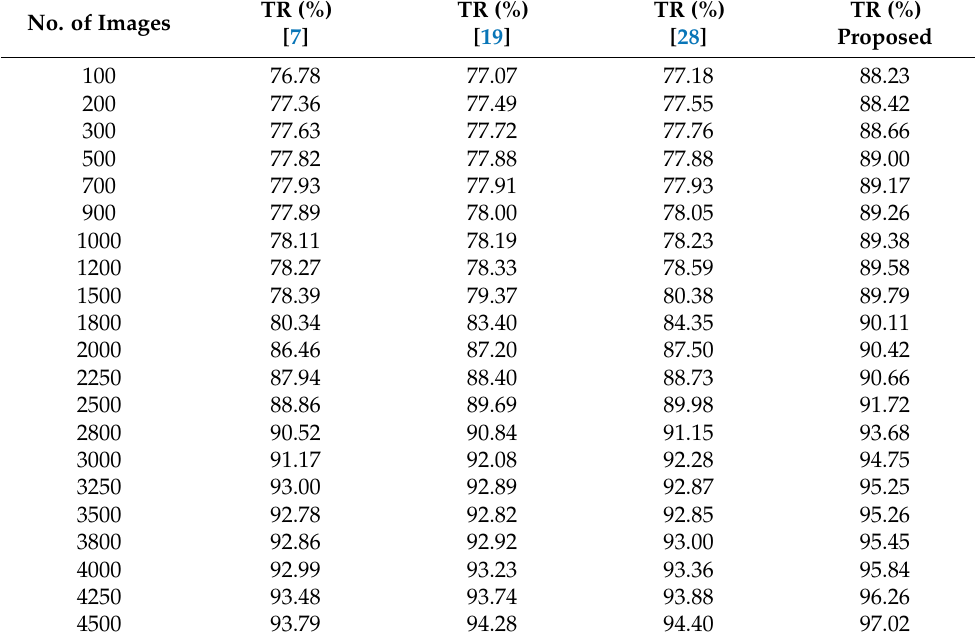
Table 3. Test recall for combined dataset.